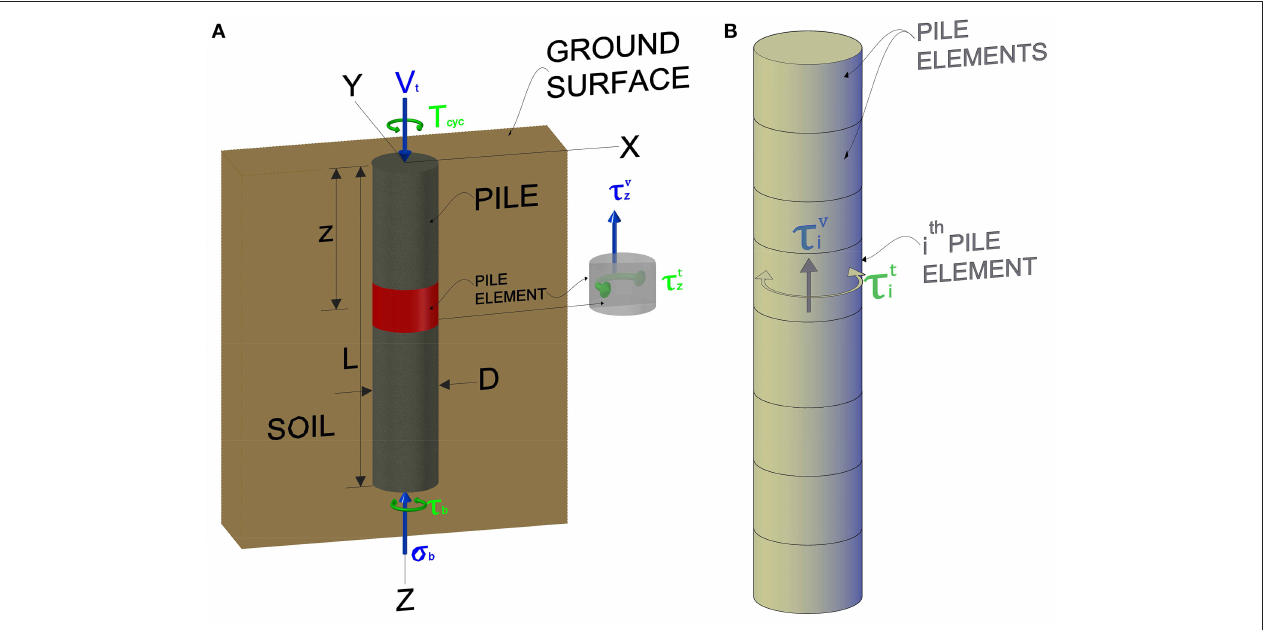
FIGURE 1 | Numerical modeling: (A) , Idealized problem (B) , BEM discretization of the pile.